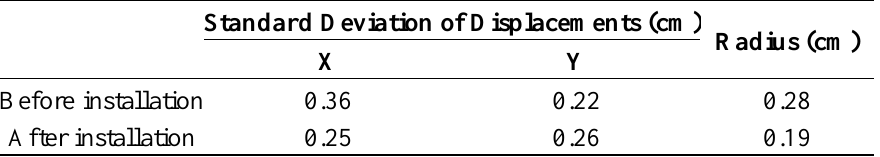
Table 2. Displacement changes from outrigger truss installation.